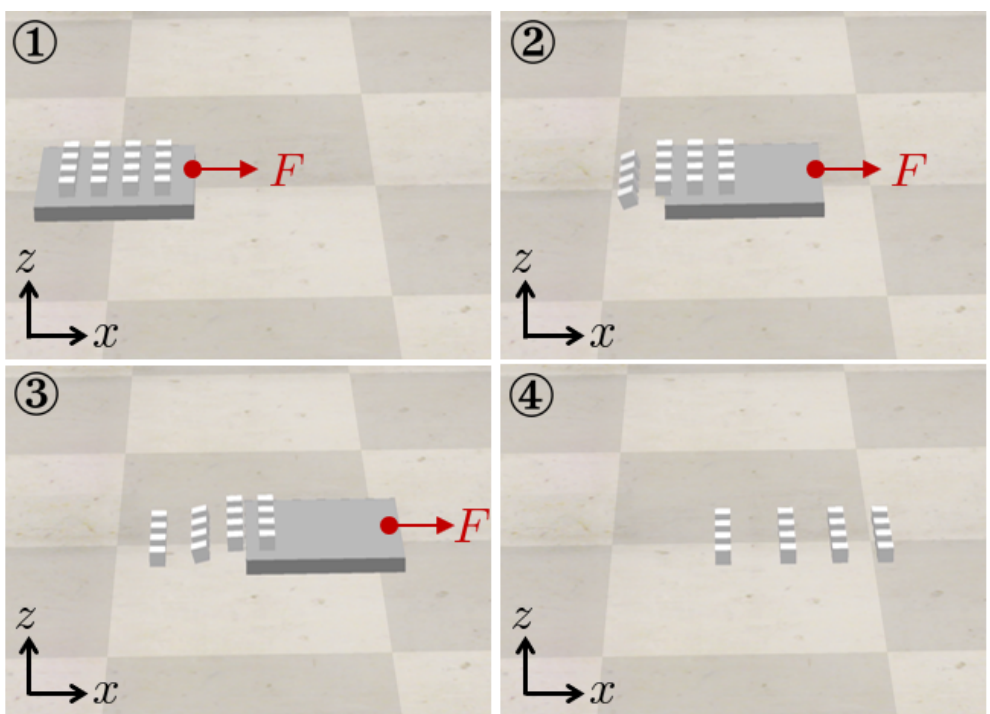
Figure 1. Snapshot of a simple scenario: 16 small cubes are placed on top of a large box and force is applied to the large box. Over time, the small cubes and the large box separate ( 1 → 4 ).